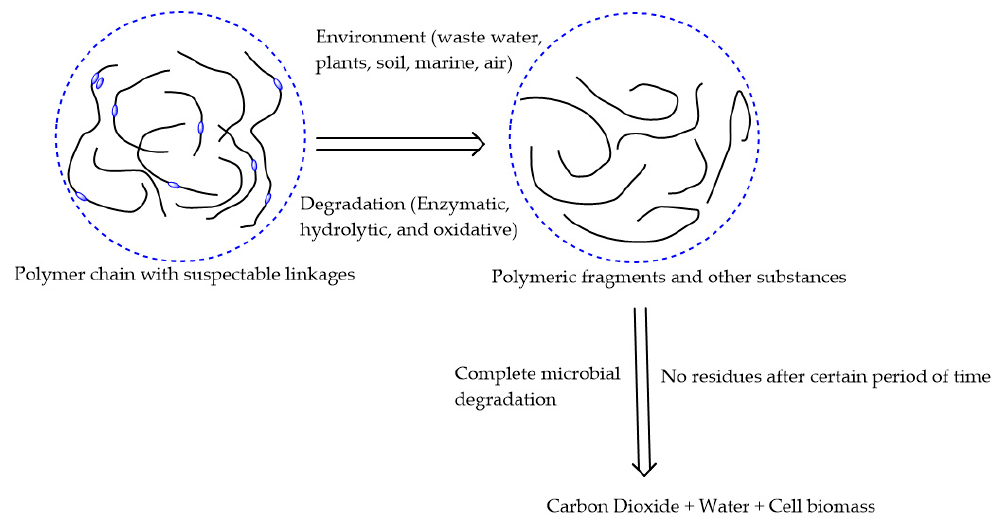
Figure 3. Biodegradation of biofiber-based composites. Adapted with permission from Reference [8]. Copyright Polymedia Publisher GmbH, 2009.